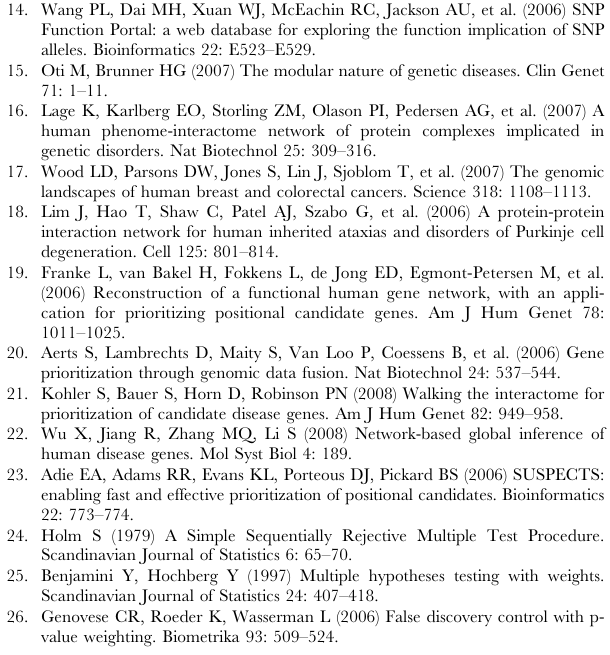
Found at: doi:10.1371/journal.pone.0014480.s004 (0.03